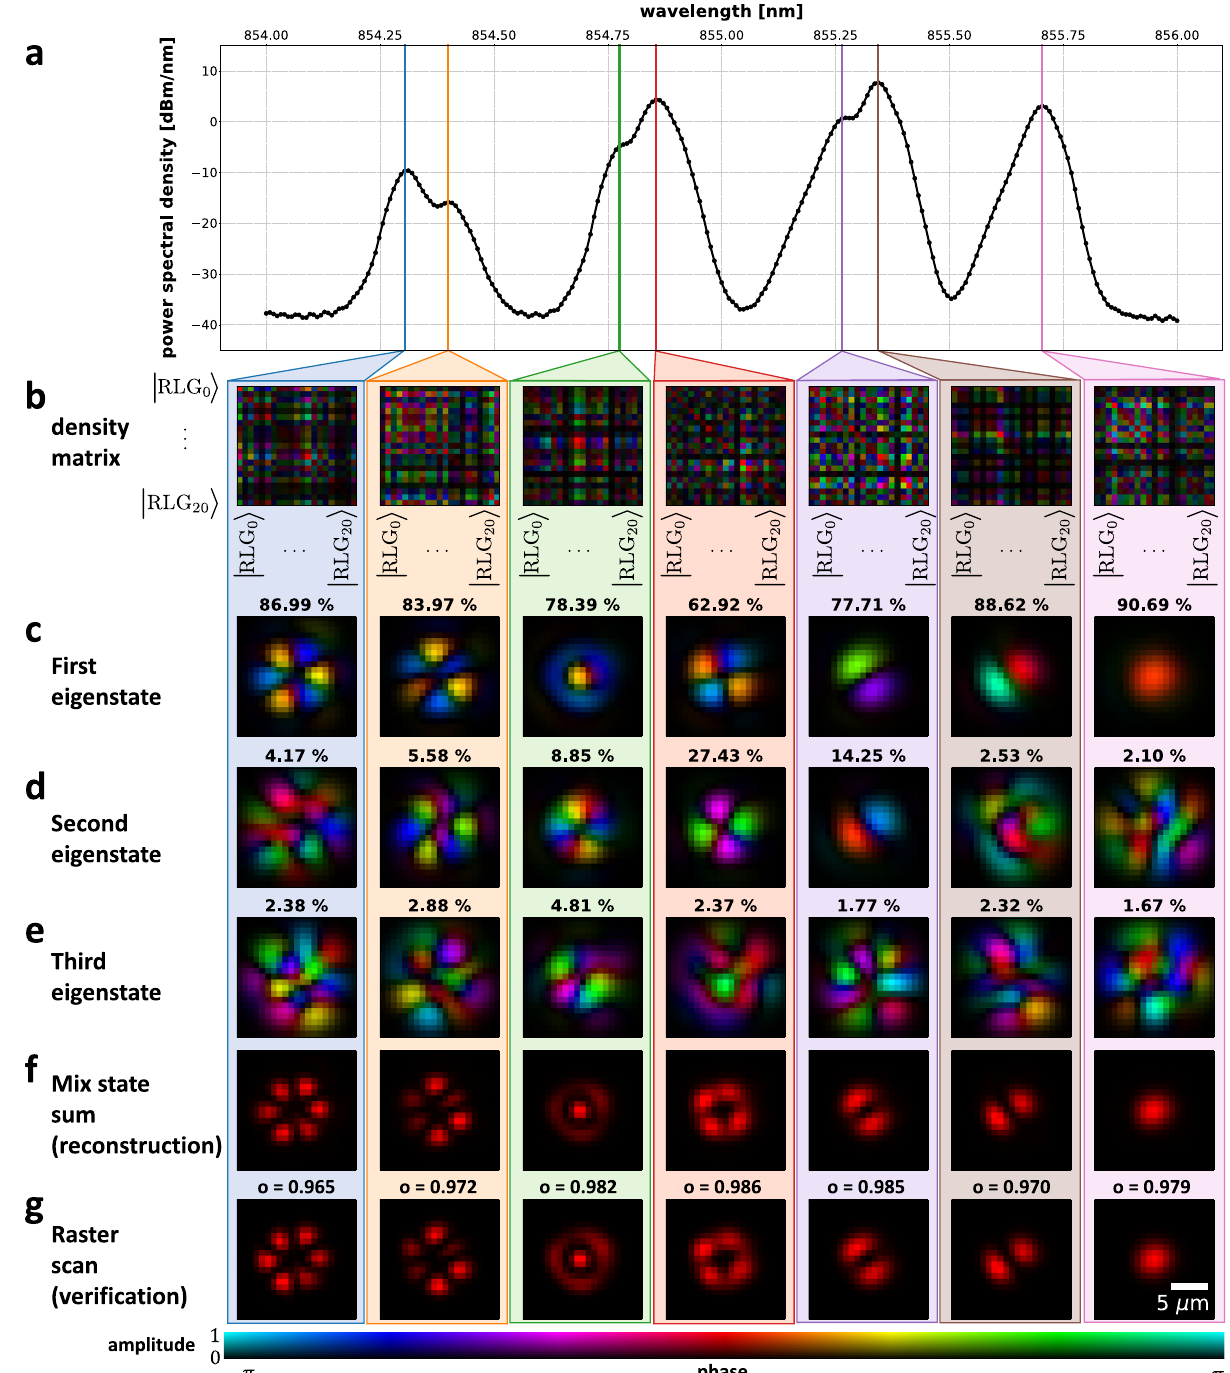
Fig. 3 Spatio-spectral analysis of VCSEL (H polarisation). a The spectrum has multiple spectral peaks, each corresponding to one or more spatial modes. b The measured density matrix expressed in RLG basis for colour-coded spectral peaks. c – e The fi rst three most dominant spatial eigenstates and their corresponding probabilities as reconstructed from the density matrix ( b ) using the RLG basis. f The probability-weighted intensity sum of all reconstructed eigenstates obtained via state tomography perfectly matches the intensity pro fi les ( g ) obtained by raster scanning the VCSEL beam over SMF by adding tilt on the SLM and collecting the spectrum for each tilt value. Quantitative agreement between ( f ) (tomography approach) and ( g ) (veri fi cation) is highlighted by the overlap integral value o evaluated in each spectral slice. The measured density matrix along with the reconstructed spatial eigenstates for each wavelength is in Supplementary Media 1. The results for the V polarisation are presented in Supplementary Note 5 and Supplementary Media